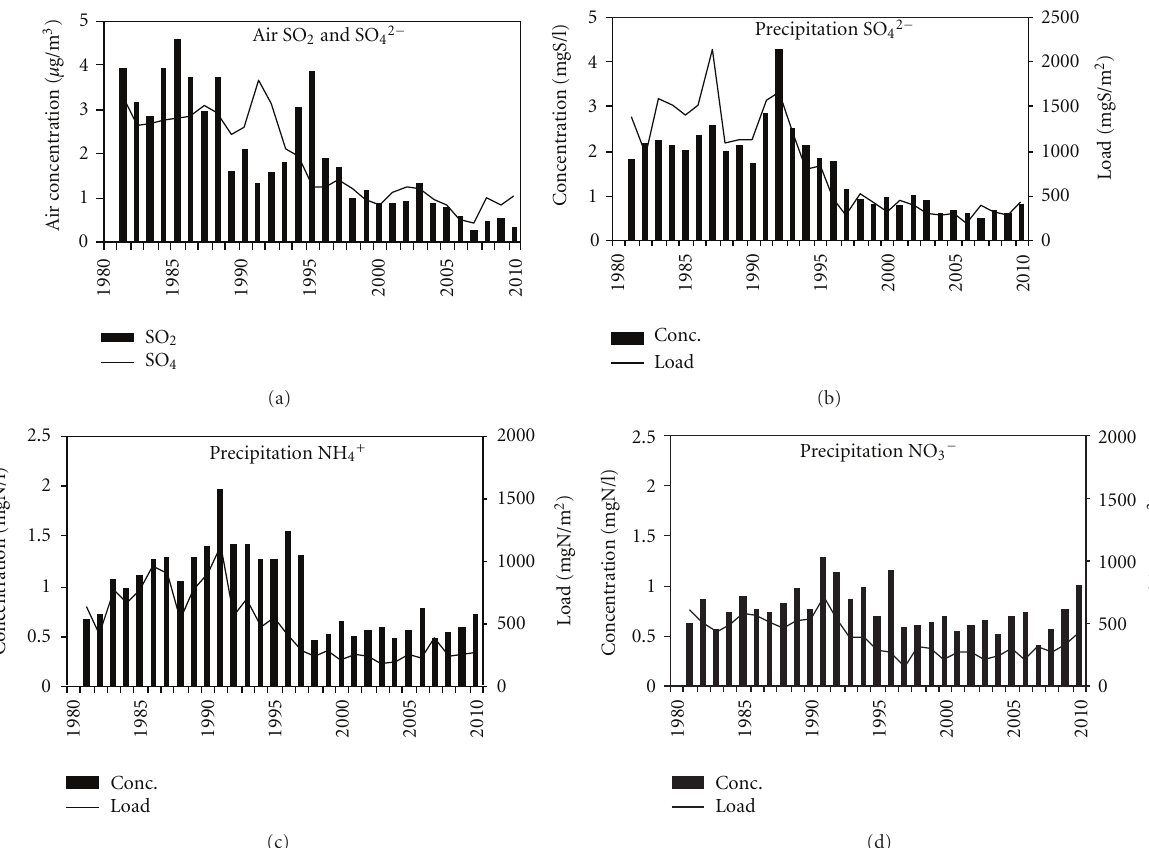
Figure 5: Main acidifying species in air and precipitation and their changes over the 30-year period.